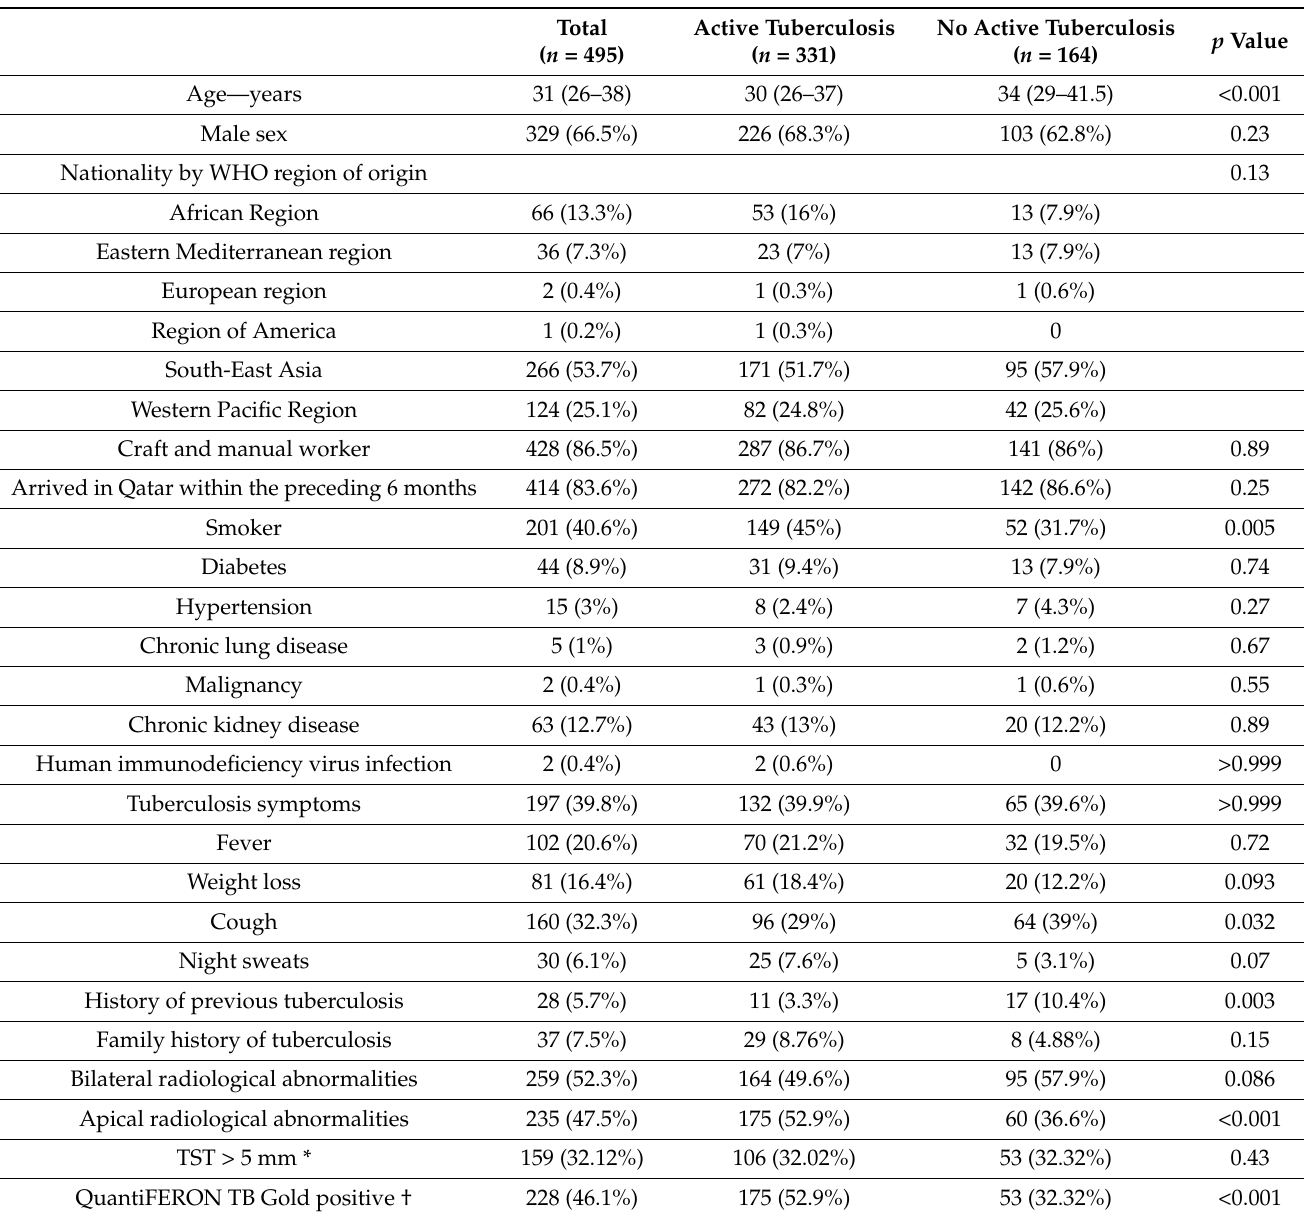
Table 1. Baseline characteristics of individuals who underwent tuberculosis screening program including bronchoscopy and post-bronchoscopy sputum